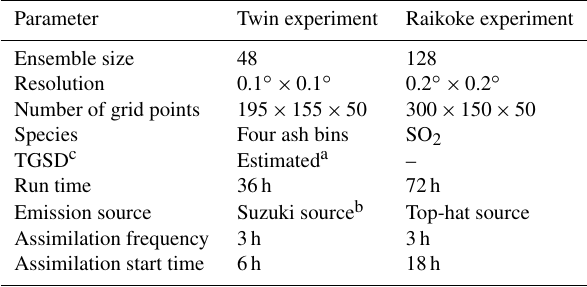
Table 3. Model configuration parameters for the numerical experi- ments considered in this